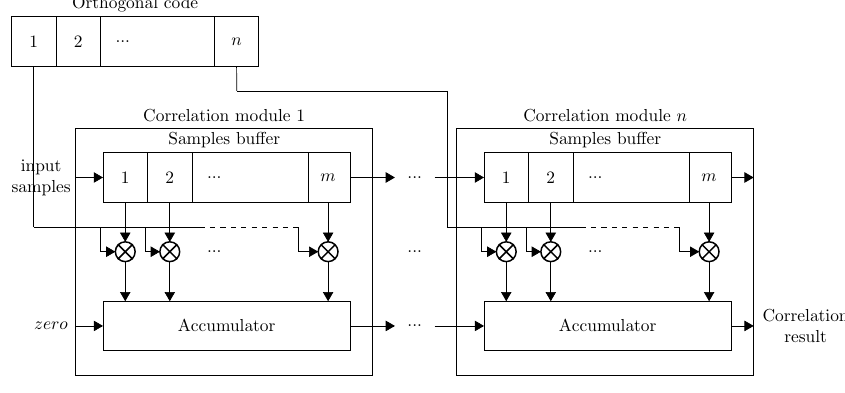
Figure 5. Naive correlator implementation.